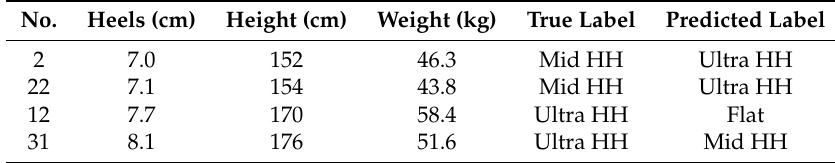
Table 6. Some subjects of failure